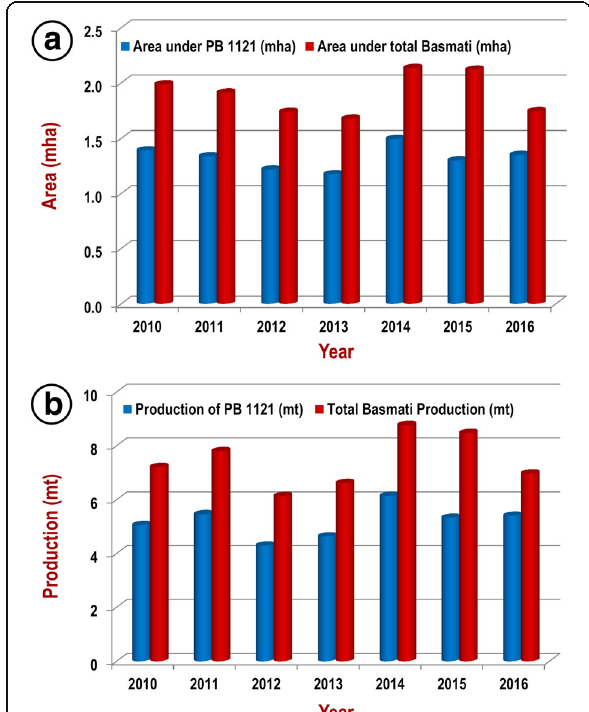
Fig. 6 Area ( a ) and yield ( b ) of Pusa Basmati 1121 compared to the totals for all Basmati